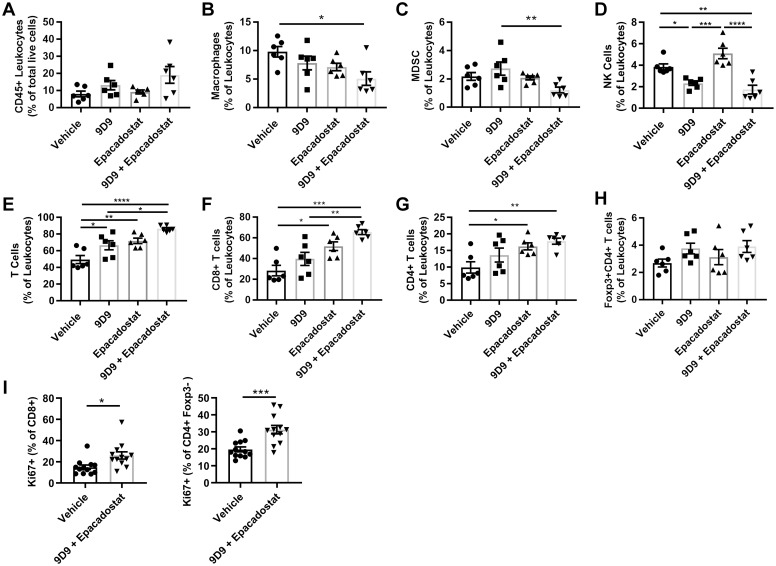
Checkpoint inhibitors increase the number of T cells in the liver of PD-1-/- mice.Mice were treated with anti-mouse CTLA-4 (9D9), lower dose (300 mg/kg BID) epacadostat or in combination for 6 weeks (A–H) or 3 weeks (I). Single cell suspensions of the whole liver were analyzed for (A) CD45+ cells, (B) CD11b+F4/80+ macrophages, (C) Gr1+CD11b+ myeloid derived suppressor cells (MDSC)s, (D) CD49b+ natural kill (NK) cells, (E) CD3+ T cells, (F) CD3+CD8+ T cells (G) CD3+CD4+ T cells, (H) Foxp3+CD4+ T cells, and (I) Ki67+ T cell subsets by flow cytometry. All data are reported as mean ± SEM. *P<0.05, **P<0.01, ***P<0.001, ****P<0.0001, n = 6 per group, one-way ANOVA with Tukey’s multiple comparisons test (A–H) or n = 12 per group, unpaired t-test (I).